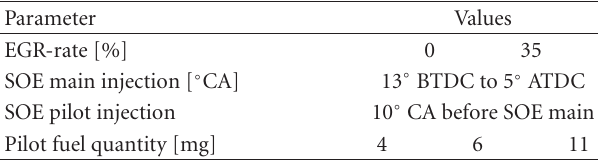
Table 1: Engine specifications and operation conditions. Table 2: Parameter